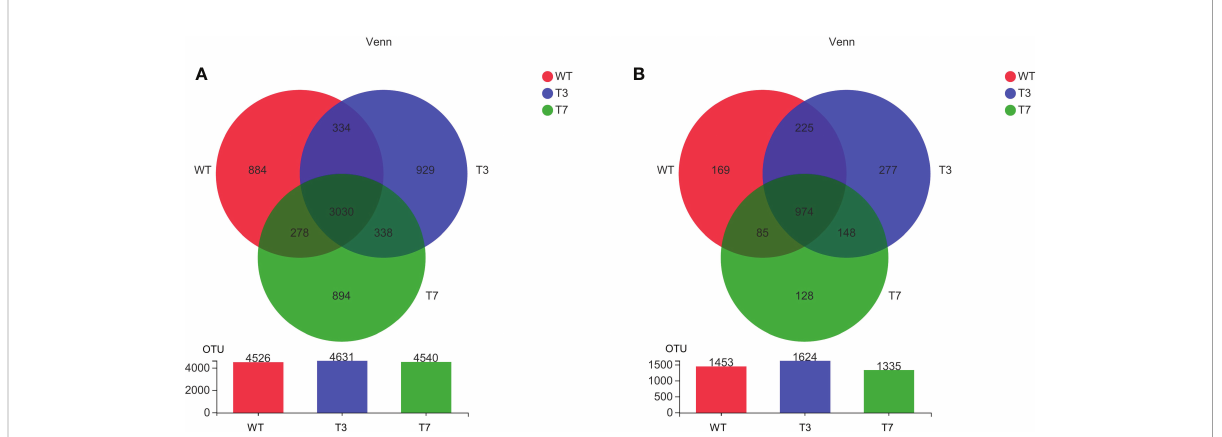
FIGURE 1 Venn diagram of the microbial community at the OTU level of wild-type and transgenic rapeseed plants ( A , bacteria; and B , fungi). Note: The number of overlapping parts represents the number of species common to multiple groups, and the number of nonoverlapping parts represents the number of species unique to the corresponding